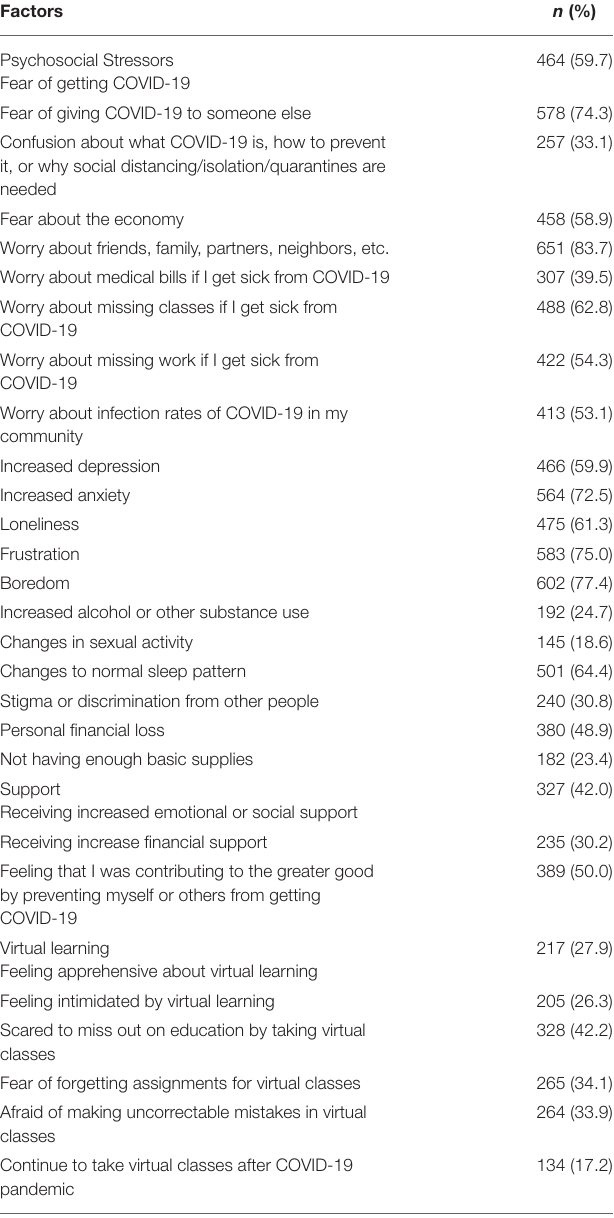
TABLE 2 | All students’ experiences during the COVID-19 pandemic ( N = 777).